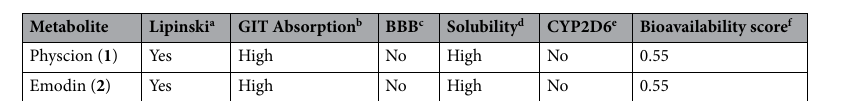
Table 3. Predicted ADME profiles of physcion ( 1 ) and emodin ( 2 ). a Predicts if the compound has a drug-like properties (follows the Lipinski rule of five). b Predicts the gastrointestinal absorption according to the white of the boiled egg. c Predicts the ability of the compound to penetrate the blood–brain barrier (BBB) according to the yolk of the boiled egg. d Predicts the solubility of each compound in water. e Predicts the cytochrome P450 inhibition. f Predicts the bioavailability score, where values > 0.5 indicate acceptable bioavailability.